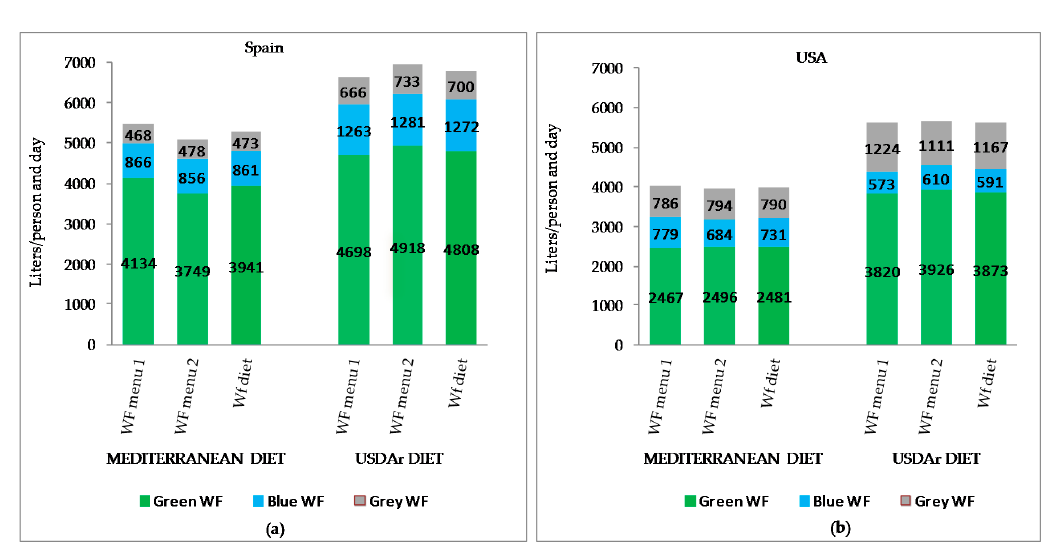
Figure 1. Green, blue and grey water footprint (WF) for WF menu1 , WF menu2 and the total WF diet of Mediterranean diet (WF diet ), and WF menu1 , WF menu2 and the total WF diet of USDAr diet (WF diet ), for: ( a ) Spain and ( b ) the US.